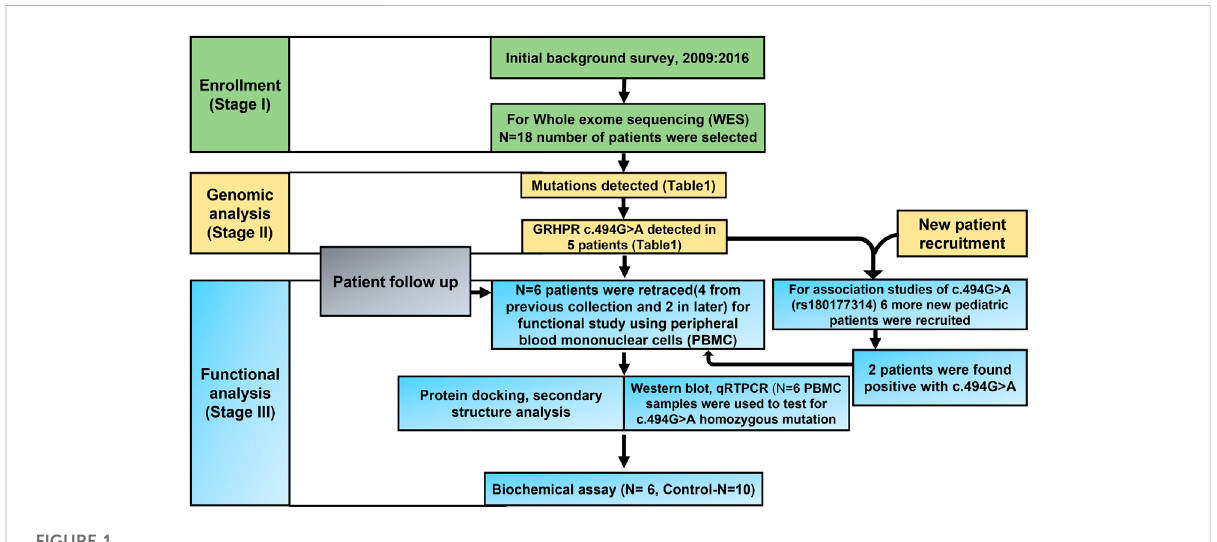
FIGURE 1 Consort diagram of the Study design.